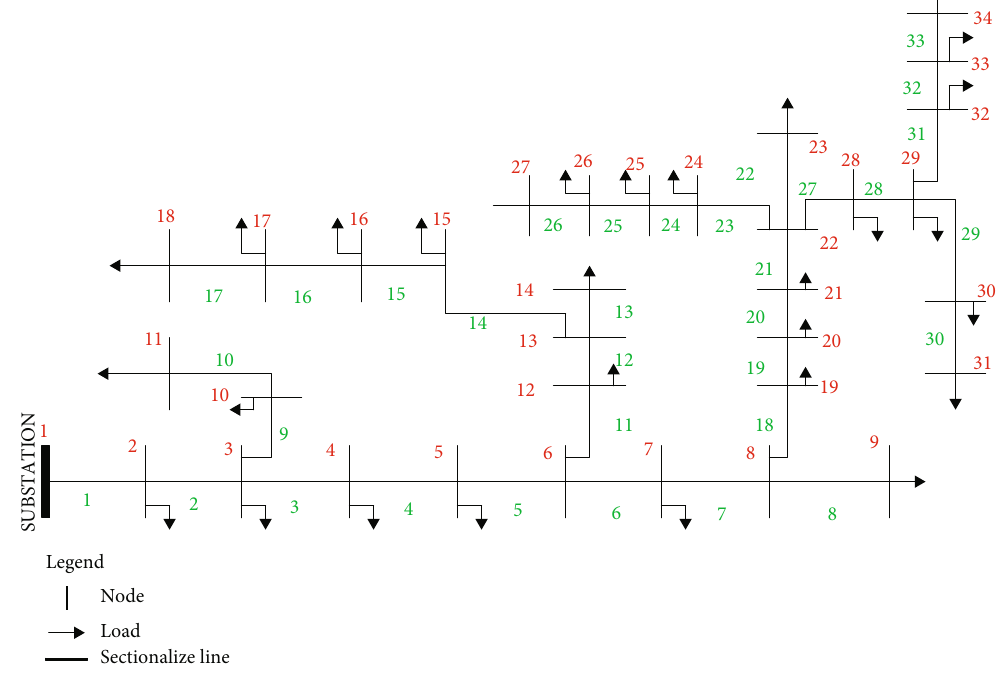
Figure 5: Single line diagram of BATA feeder